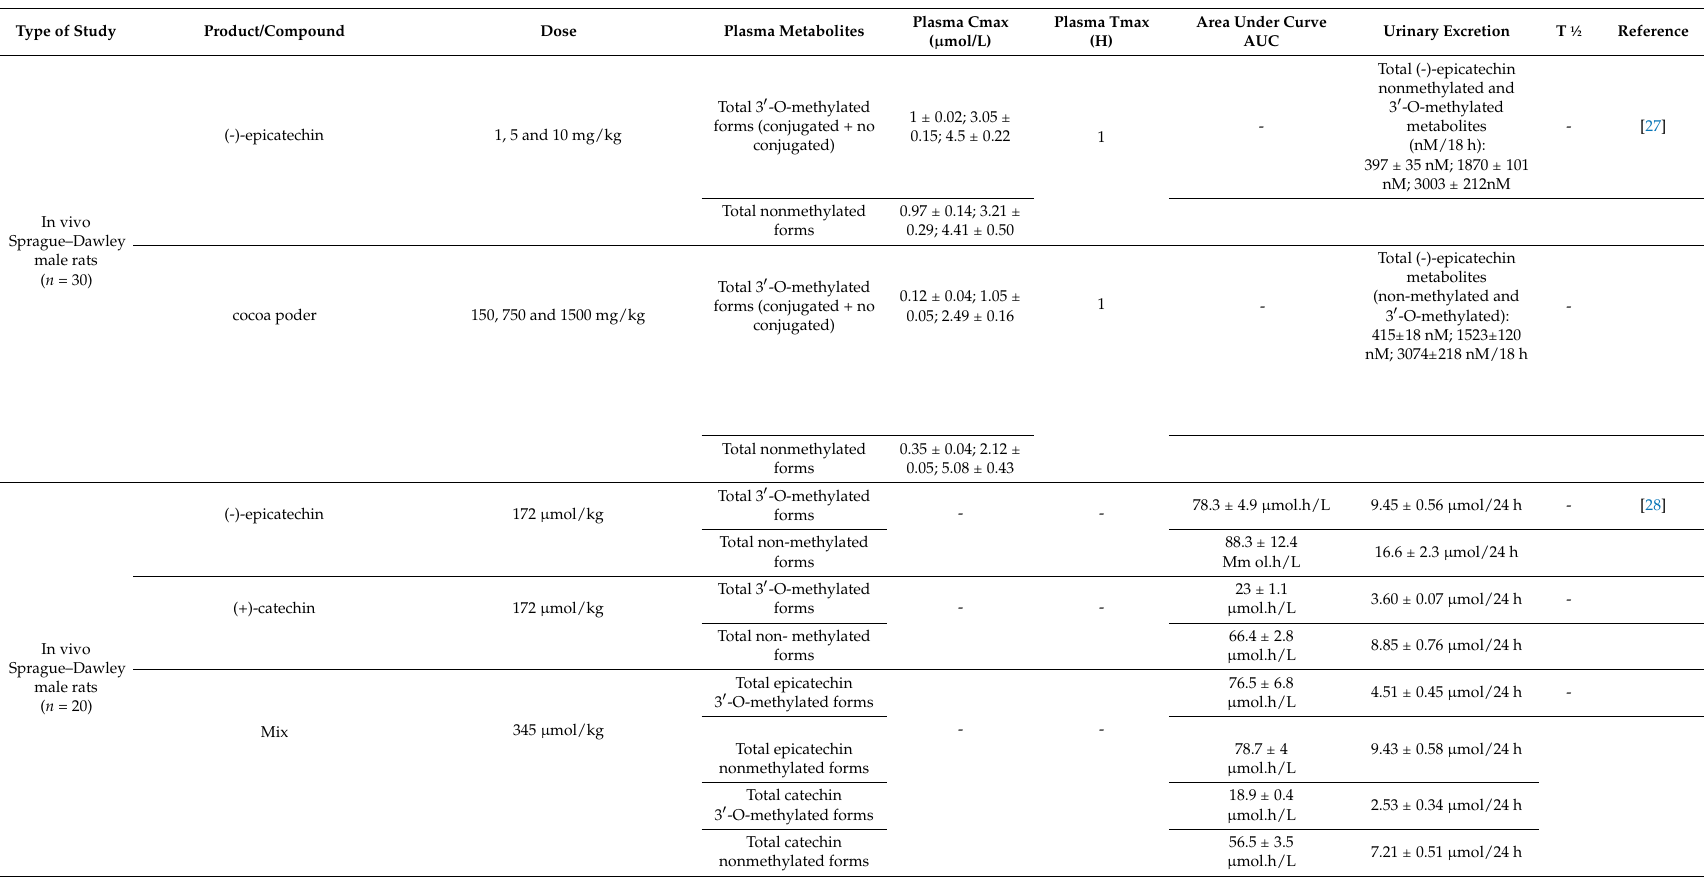
Table 1. Flavanols